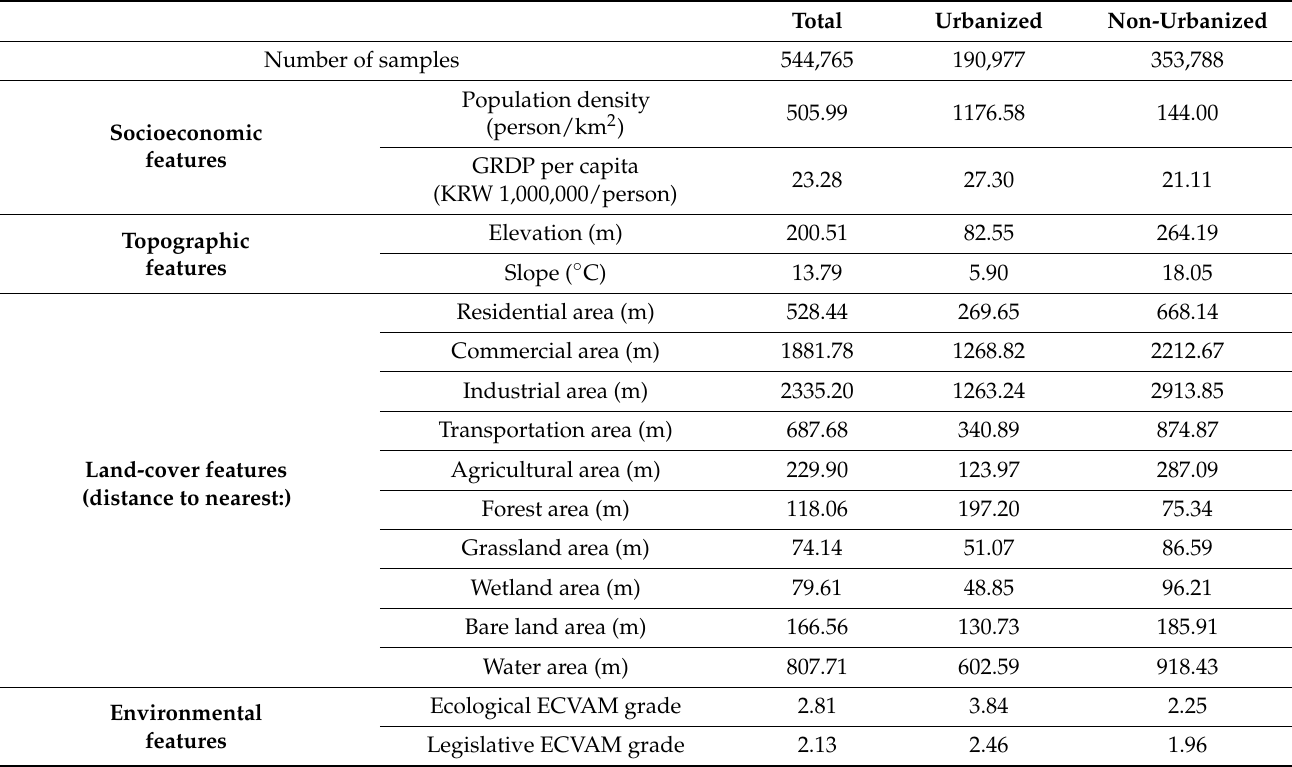
Table 3. Comparison between urbanized and non-urbanized area.